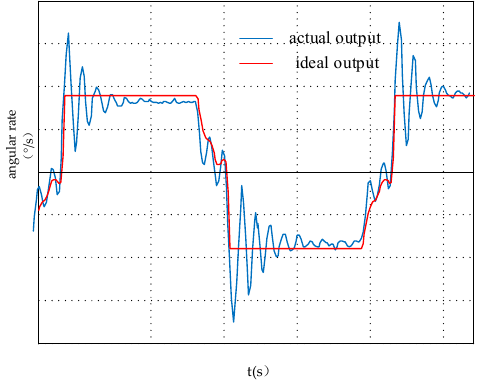
Figure 4. The ideal and actual output angular rate of the motor.